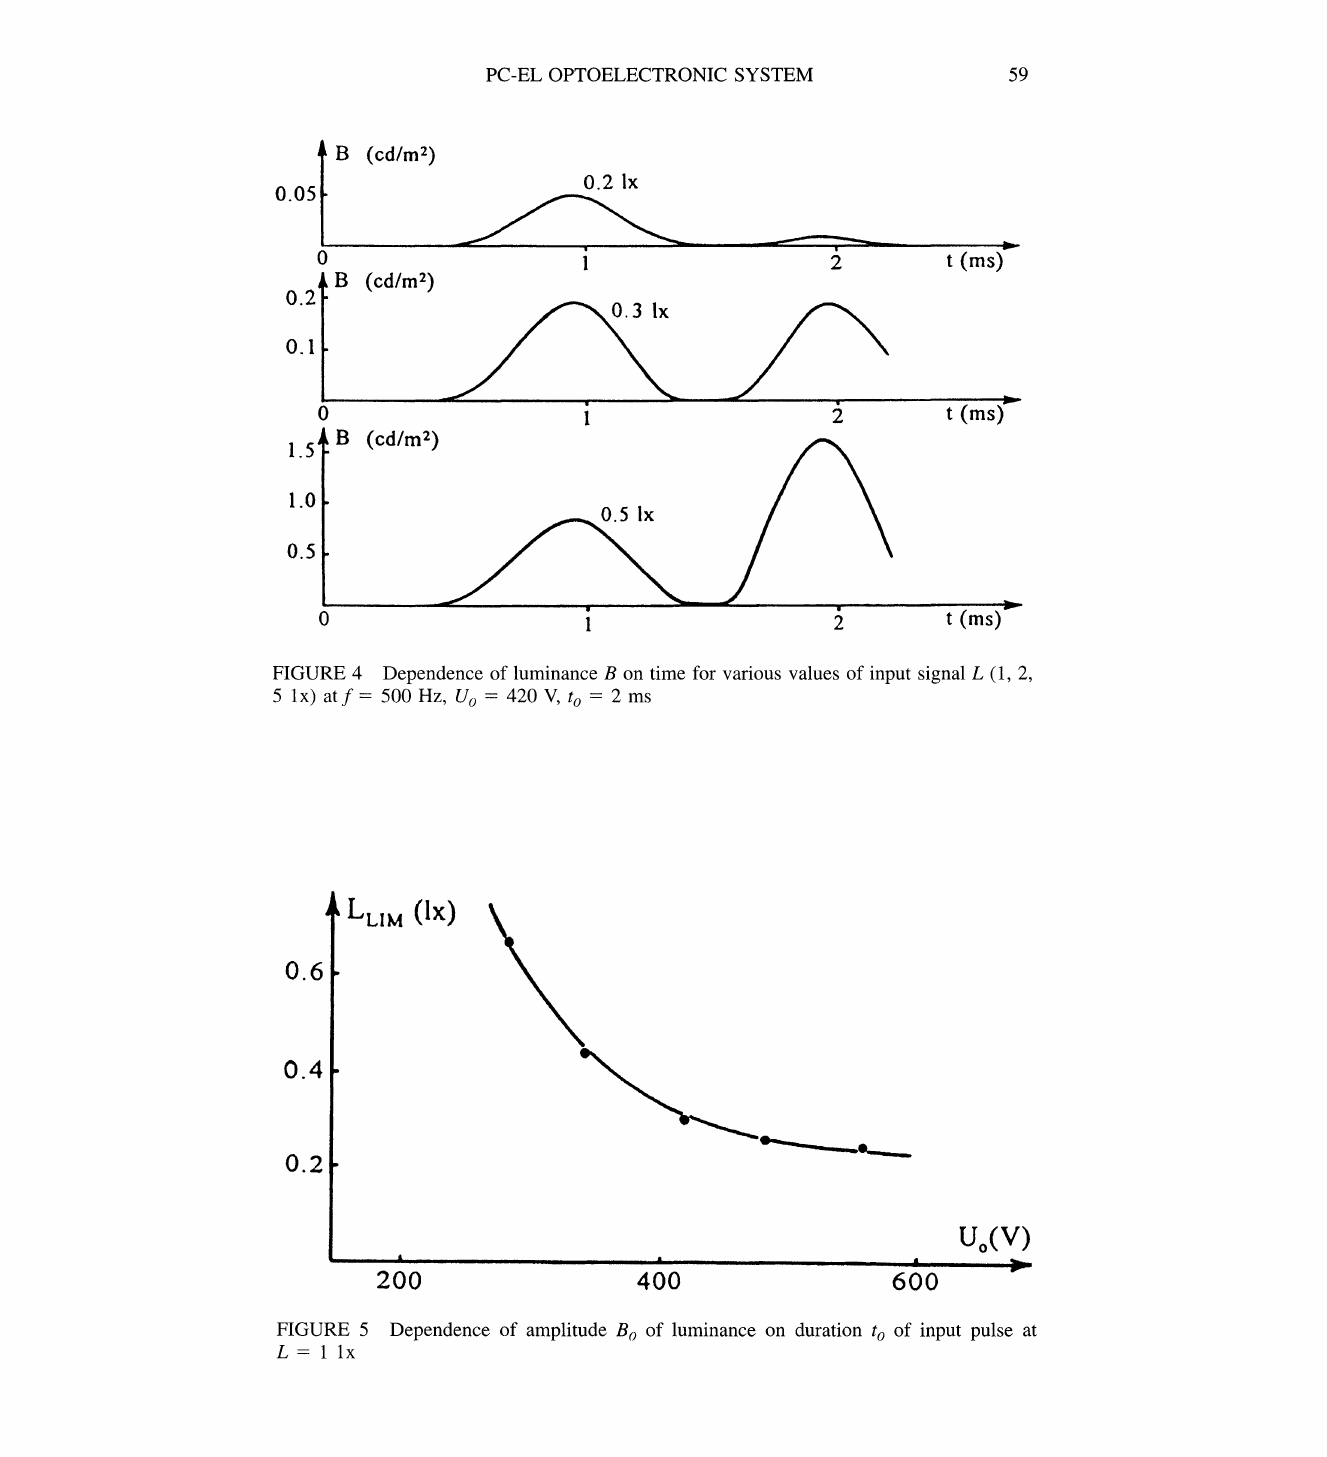
FIGURE 5 Dependence of amplitude Bo of luminance on